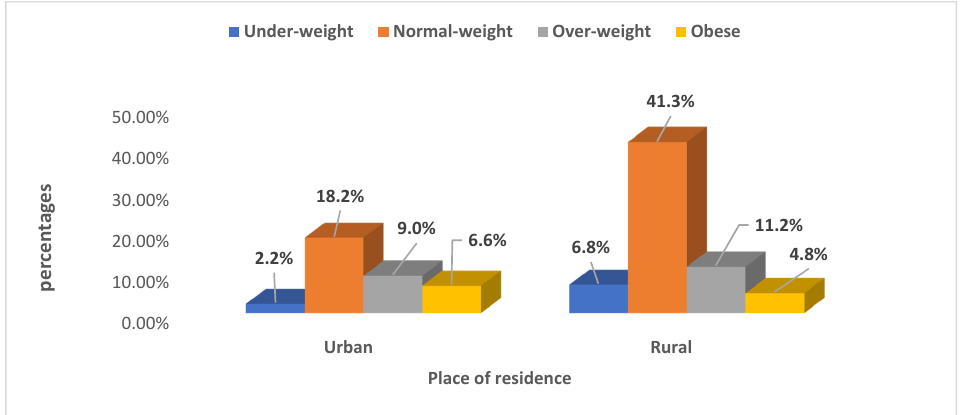
Figure 2. Body weight among women of childbearing age (15–49 years) by urban-rural variations in Nigeria. Source: NDHS, 2018.